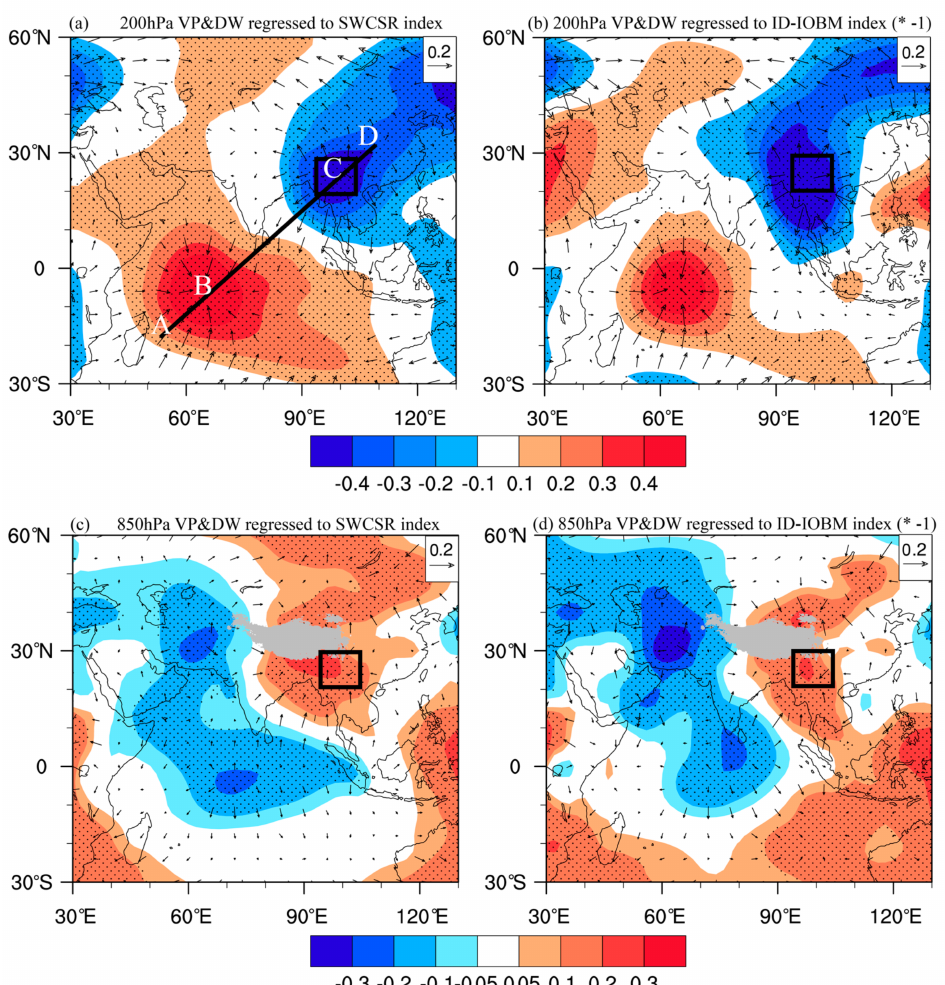
Figure 5. Regressed divergent winds (vectors; m/s) and velocity potentials (shading; 10 6 m 2 /s) at ( a , b ) 200 hPa and ( c , d ) 850 hPa against ( a , c ) the SWCSR index and ( b , d ) the ID-IOBM index. Line ABCD in ( a ) is the location for slice in height analysis hereafter. The rectangles indicate Southwestern China. “*” denotes “multiply by”. Black dots denote areas significant at the 95% confidence